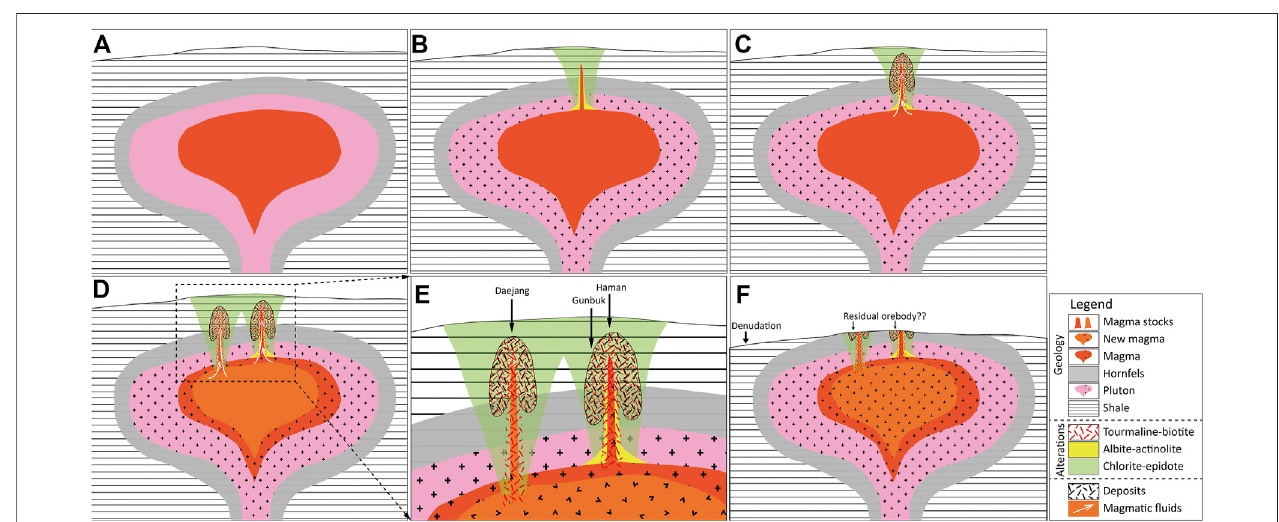
FIGURE15| SchematicgeologicalmodeloftheHaman,Gunbuk, andDaejang deposits. (A) Cretaceous Jindonggranitoidintrusions formed widespread hornfels in Jindong-Haman shale. (B) Magma stocks intruded into the hornfels and created a pervasive chlorite-epidote alteration. Albite-actinolite alterations around the deep- center of magma stocks were formed by magmatic-hydrothermal fl uid. (C) Magmatic fl uids derived from stocks formed the quartz veins with a tourmaline-(magnetite)- biotite alteration and main-stage ore-mineralization in the Haman and Gunbuk deposits. (D) Possibly later magmatic fl uids derived from the stocks of more crystalized magma formed the base metal-rich quartz vein with a tourmaline-biotite alteration in the Daejang deposit. (E) The Haman deposit, which was formed under relatively high T-P conditions, was formed near the upper and central part of the magma stock, whereas the Gunbuk deposit was formed at its periphery. The Daejang deposit was formed at a similar T-P to the Gunbuk deposit, but the Daejang deposit may have been formed by a more differentiated and possibly physically separated magma. (F) Denudation to the current surface level. If a residual economic orebody remains underground, it might exist in the area around the Gunbuk and the Daejang